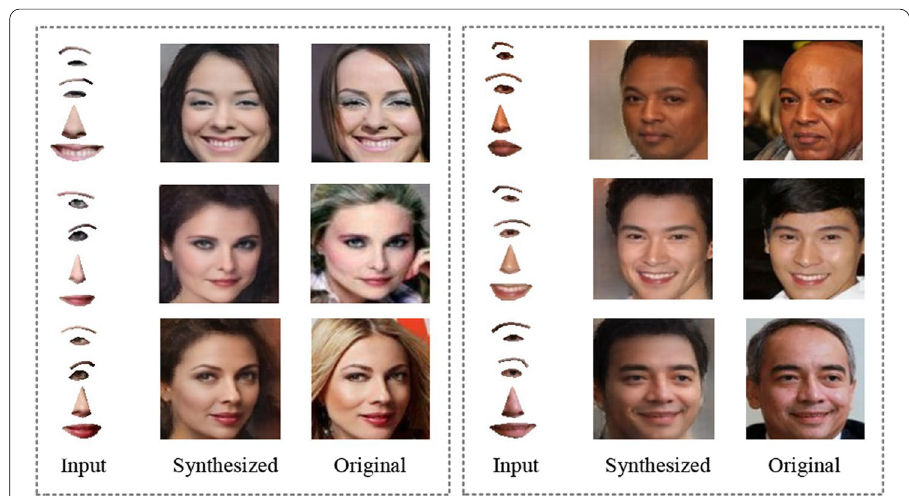
Fig. 4 Face images generated on the test dataset. In each panel from left to right are facial-part patches, our synthesized facial images and the original facial images (the ground